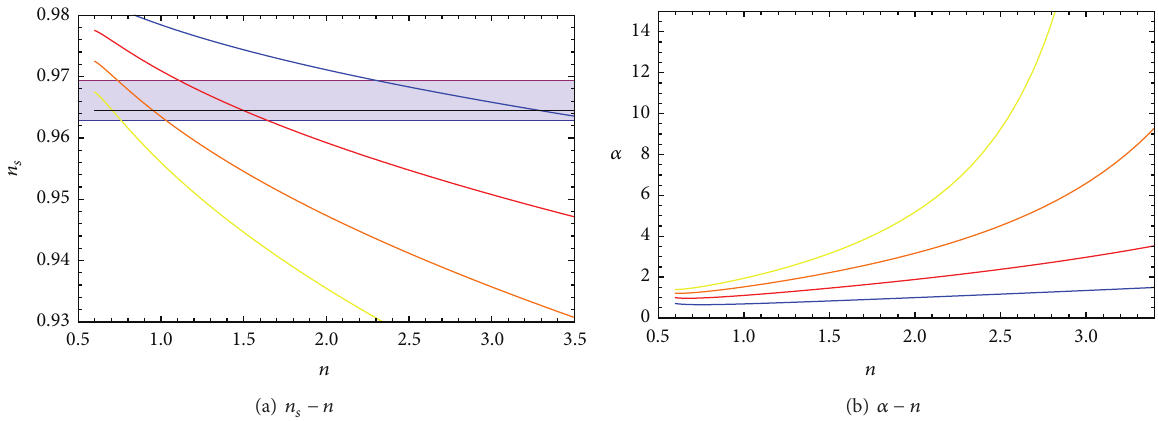
Figure 1: (a) The scalar spectra index versus 𝑛 . (b) The potential power parameter 𝛼 is depicted versus 𝑛 ; for four different values of tensor- to-scalar ratio as 𝑟 = 0 . 05 (blue line), 𝑟 = 0 . 09 (red line), 𝑟 = 0 . 11 (orange line), and 𝑟 = 0 . 14 (yellow line).